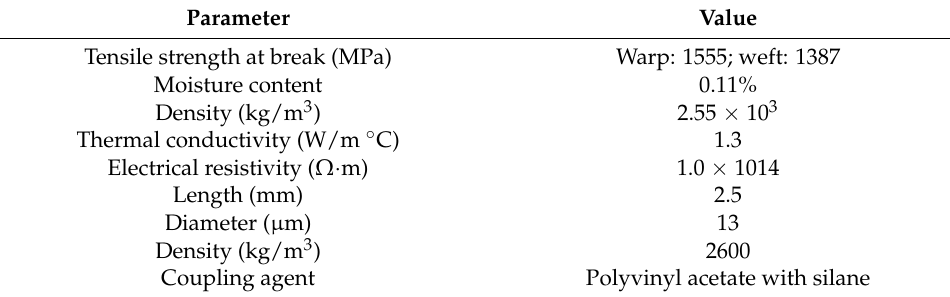
Table 1. Physical and mechanical properties of glass fiber.